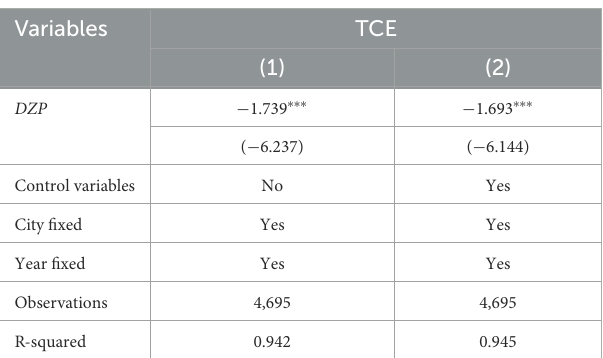
TABLE 3 PSM-DID regression